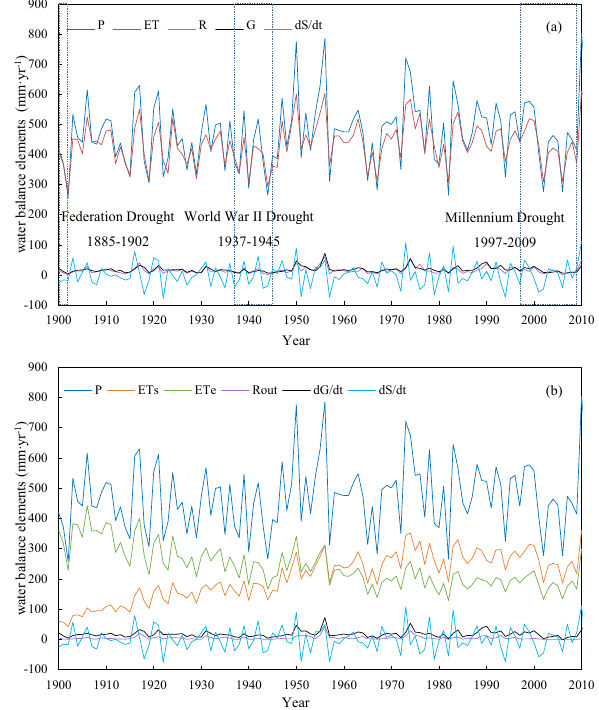
Figure 2. Water balance element changes in the MDB from 1900 to 2010 in the conventional water balance (a) and in the socio- hydrological water balance (b)